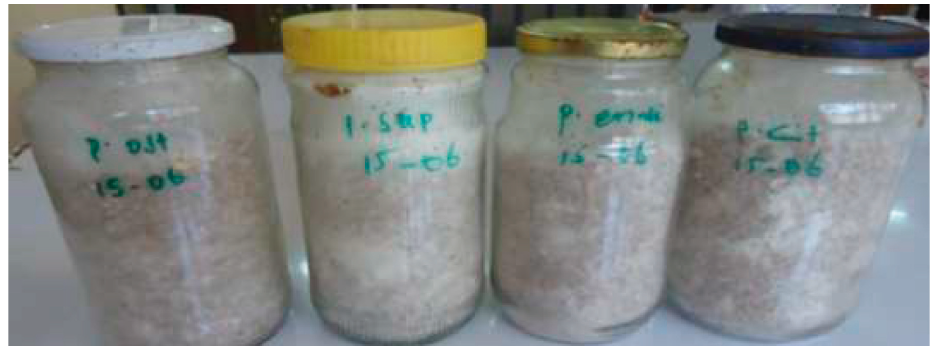
Figure 1: The four Pleurotus species spawn grown on sorghum after 20days of Table 2: Spawn running (mycelia development) and primordial (pinhead) formation days of the four Pleurotus species on different substrates.